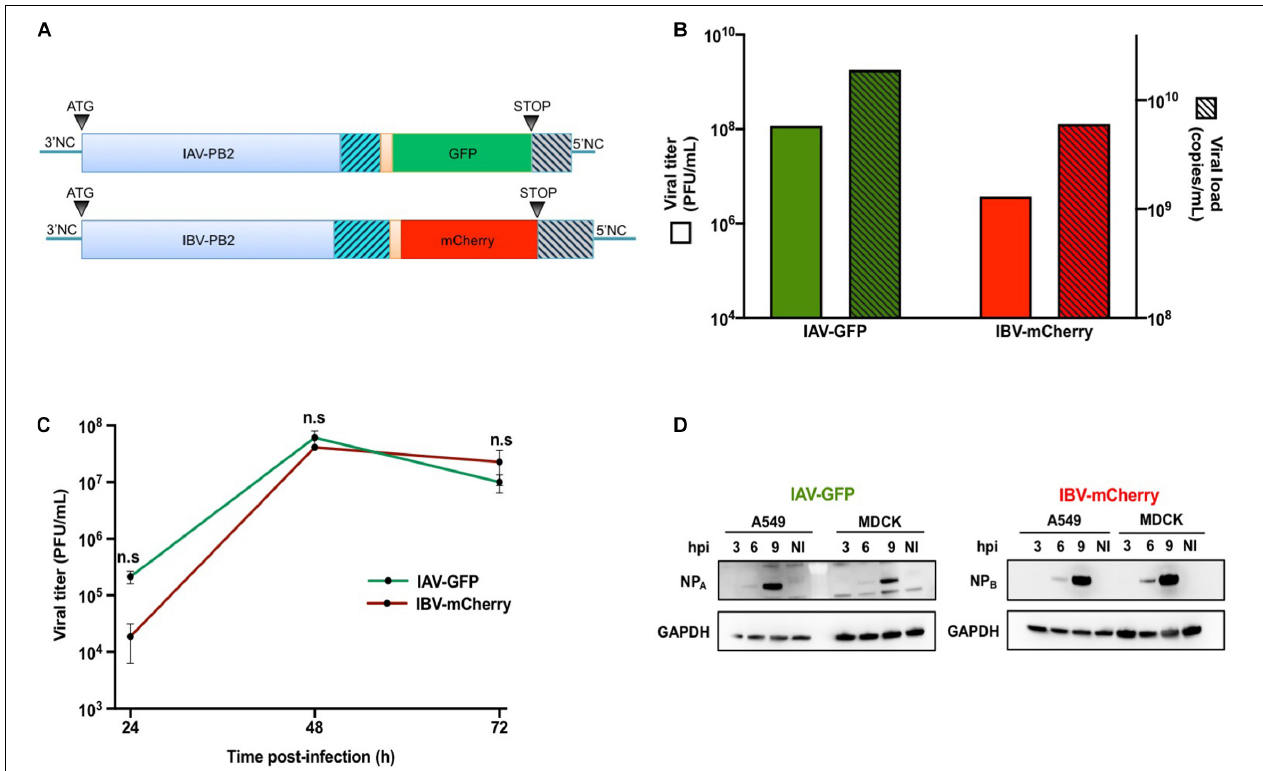
FIGURE 1 | Production and characterization of IAV-GFP and IBV-mCherry recombinant viruses. (A) Schematic representation of the IAV-PB2-GFP and IBV-PB2-mCherry segments. PB2: PB2 coding sequence from A/WSN/33 (760 aa) or B/Brisbane/60/2008 (770 aa) viral strains. Orange region: sequence encoding porcine teschovirus-1 2A peptide (22 aa) with AAA linker. GFP/mCherry: flu-codon-optimized sequence encoding the GFP (240 aa) or mCherry (236 aa) fluorescent protein. Gray hatched region: duplication of the last 109 nt (IAV) or 153 nt (IBV) coding for the PB2 protein. Blue hatched region: C-terminal region of PB2 in which silent (non-coding) nucleotide changes were introduced. 3 (cid:48) NC (27 nt for IAV and 23 nt for IBV) and 5 (cid:48) NC (34 nt for IAV and 60 nt for IBV): non-coding regions of the PB2 segment. (B) The IAV-GFP and IBV-mCherry infectious titers were determined by plaque assay and expressed in Plaque Forming Units (PFU) per mL (green and red solid bars, respectively; left axis). The corresponding titers in physical particles were determined by RT-qPCR targeting the M (for IAV) and HA (for IBV) genomic segments, and expressed in copy numbers per mL (green and red hatched bars, respectively, right axis). (C) MDCK cells were infected with IAV-GFP or IBV-mCherry at a MOI of 0.001 PFU/cell and viral titers in the supernatants collected at 24, 48, and 72 h post-infection were determined by plaque assay. The mean ± S.D. of biological duplicates is shown. Two-way ANOVA test: multiple comparison, Tukey test, α = 0.05, n.s, not significant. (D) A549 or MDCK cells were infected